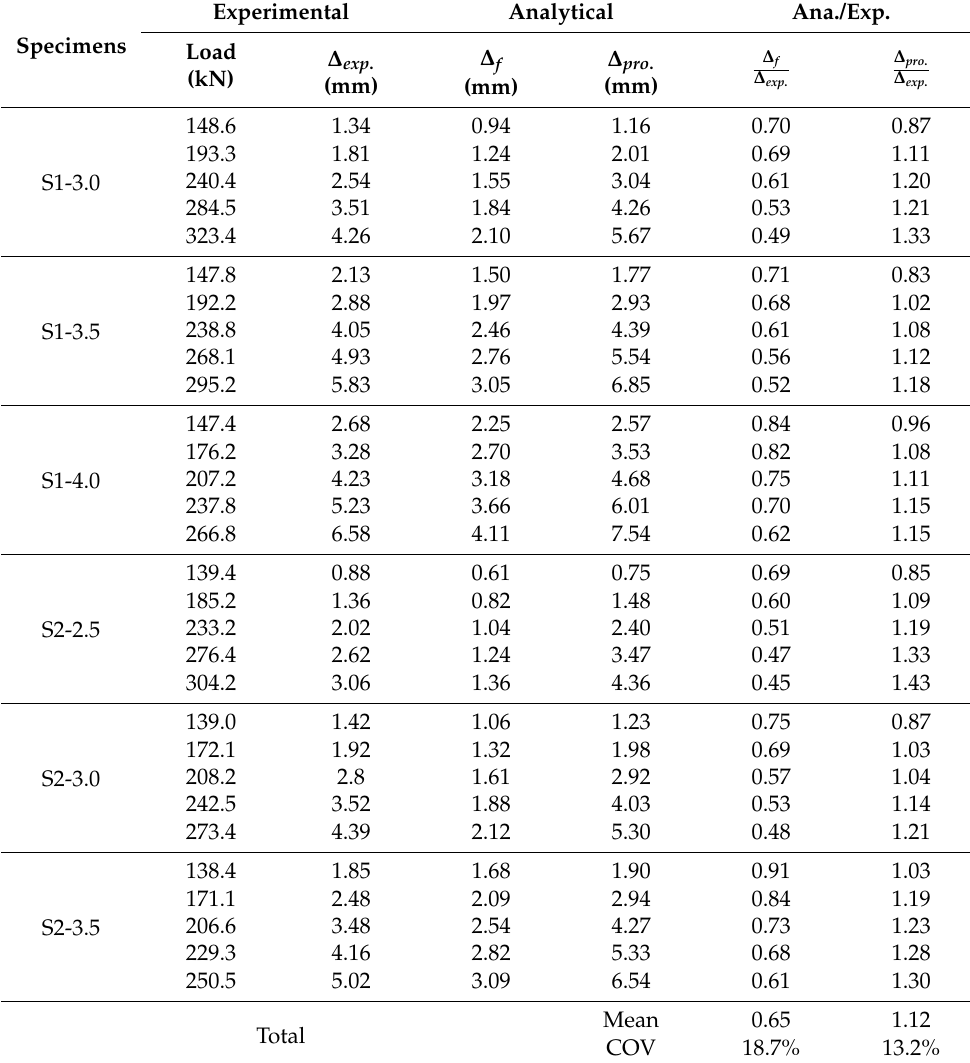
Table 4. Prediction results of deflection of specimens for each load